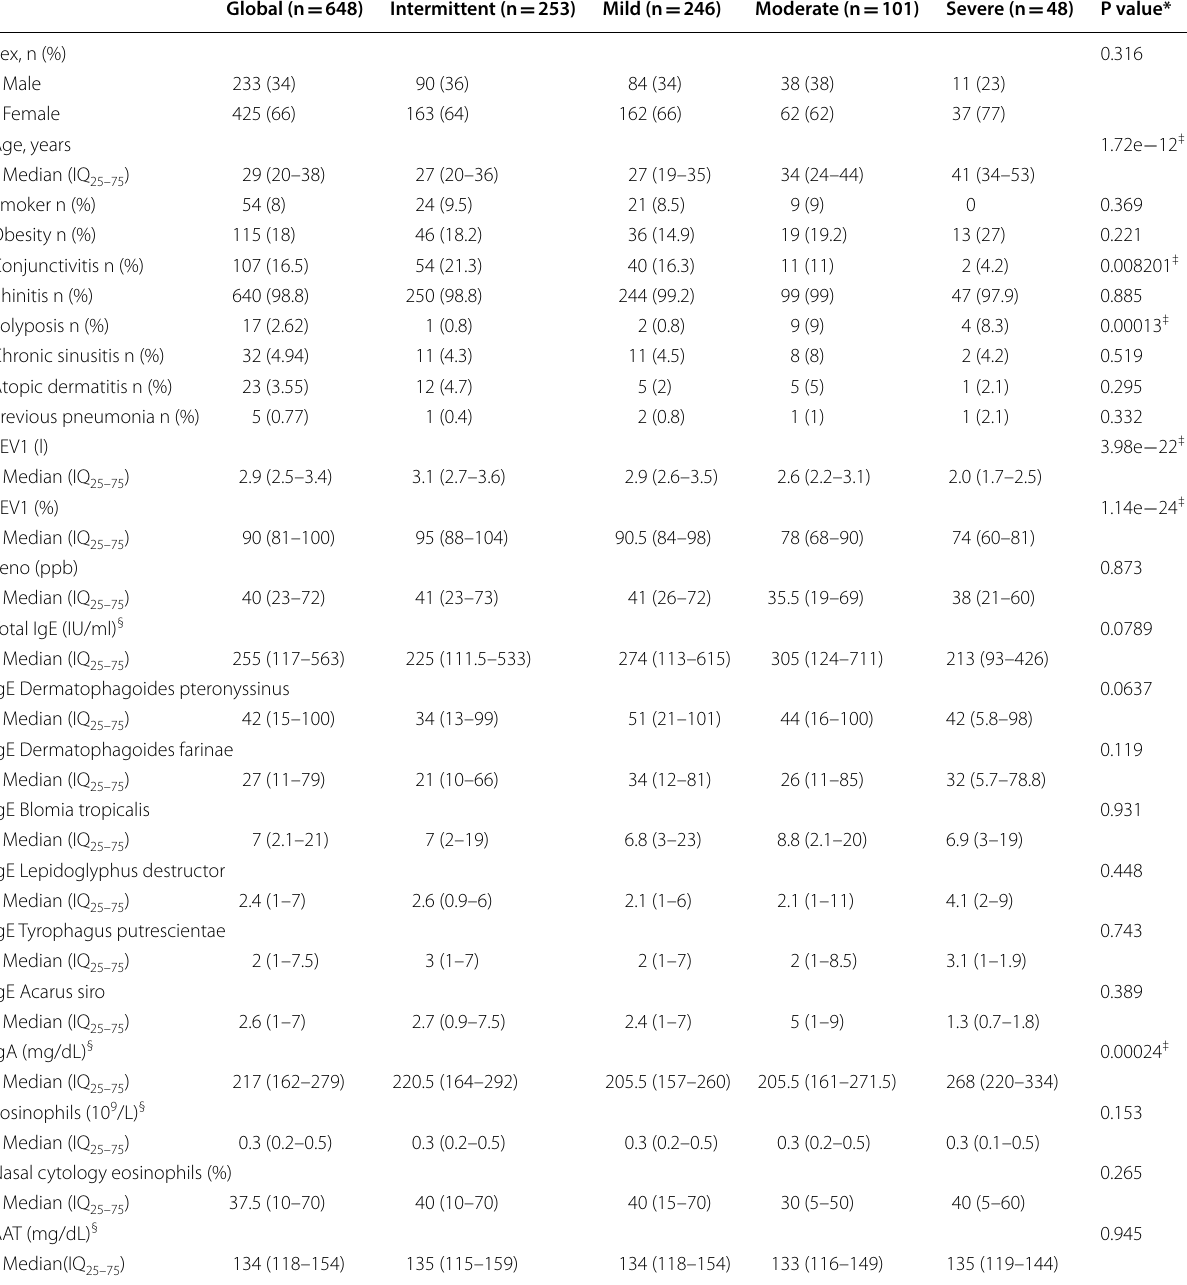
Table 1 Demographic, clinical and analytical features of the studied